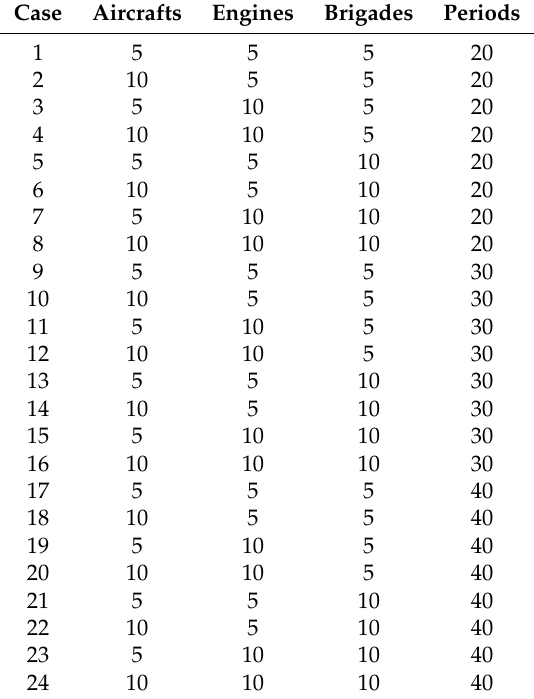
Table 4. Resource configurations for the simulated